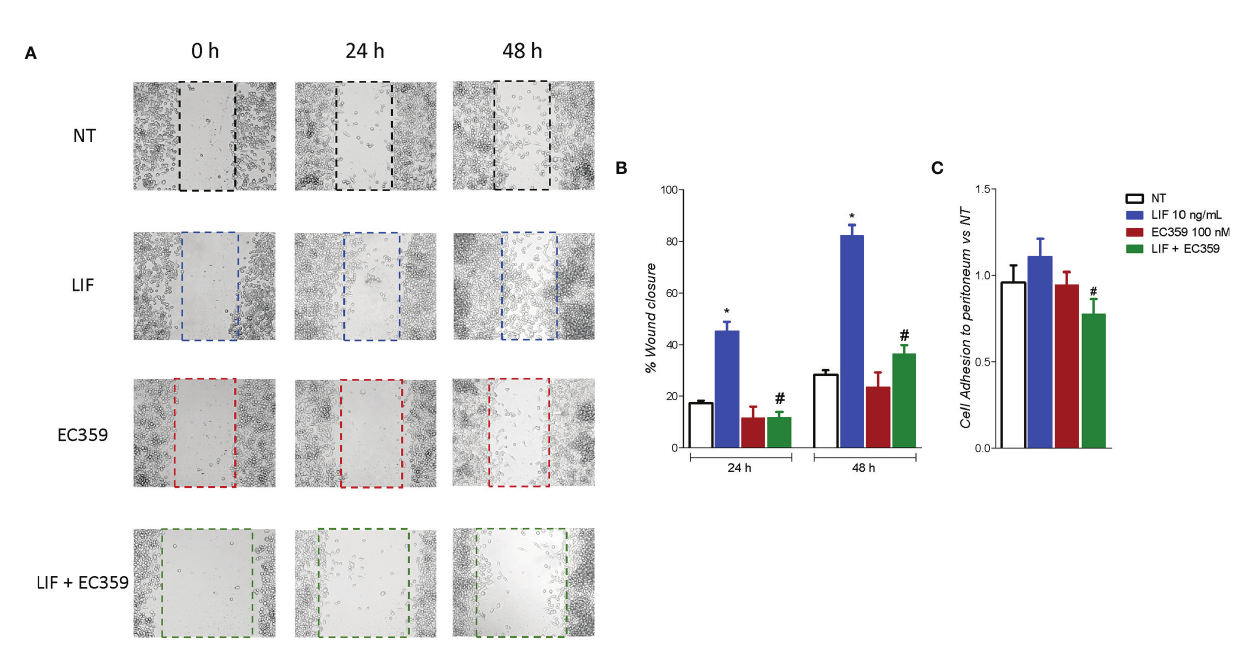
FIGURE 8 | LIFR antagonism inhibits MKN45. (A, B) A scratch wound healing assay is shown. MKN45 cell monolayers were scraped in a straight line using a p200 pipette tip to create a “ scratch ” , and then, they are left untreated or primed with LIF (10 ng/ml), EC359 (100 nM), and LIF + EC359. The wound generated was imaged at 0, 24, and 48 h of incubation with the indicated compounds. (A) The images show cell migration at the three times point indicated. (B) Images obtained points were analysed measuring scraped area and its closure vs. the fi rst time point at 0 h. Results are the mean±SEM of three samples per group. (C) Cell adhesion to peritoneum. Experiment was conducted in quintuplicate (* represents statistical signi fi cance versus NT, and # versus LIF,